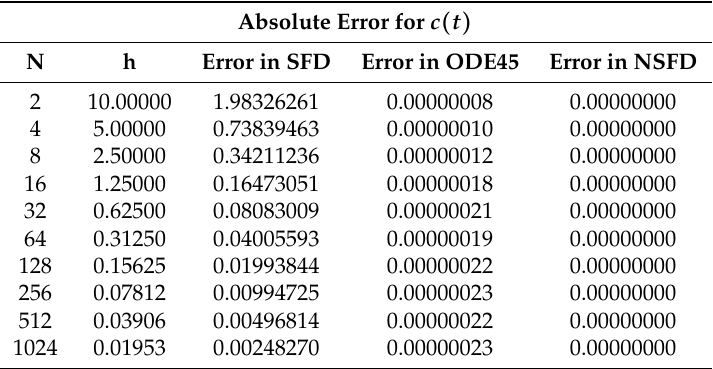
Table 5. The absolute error results for the system of equations given by (14) for p ( t ) with